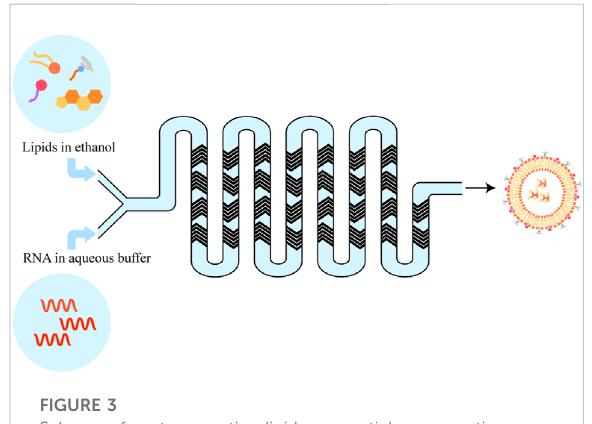
FIGURE 3 Scheme of next-generation lipid nanoparticles preparation.